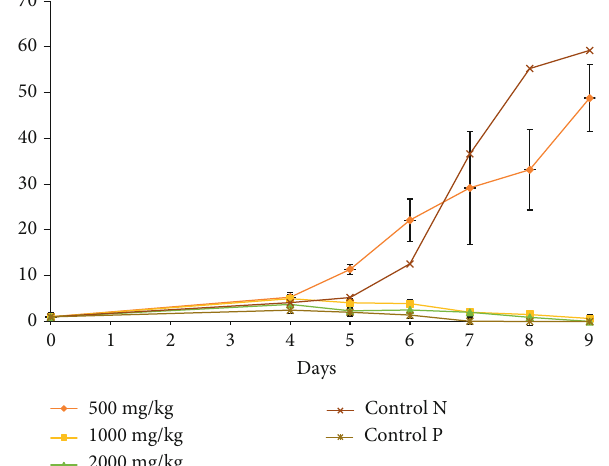
Figure 1: E ff ect of E. cylindricum on